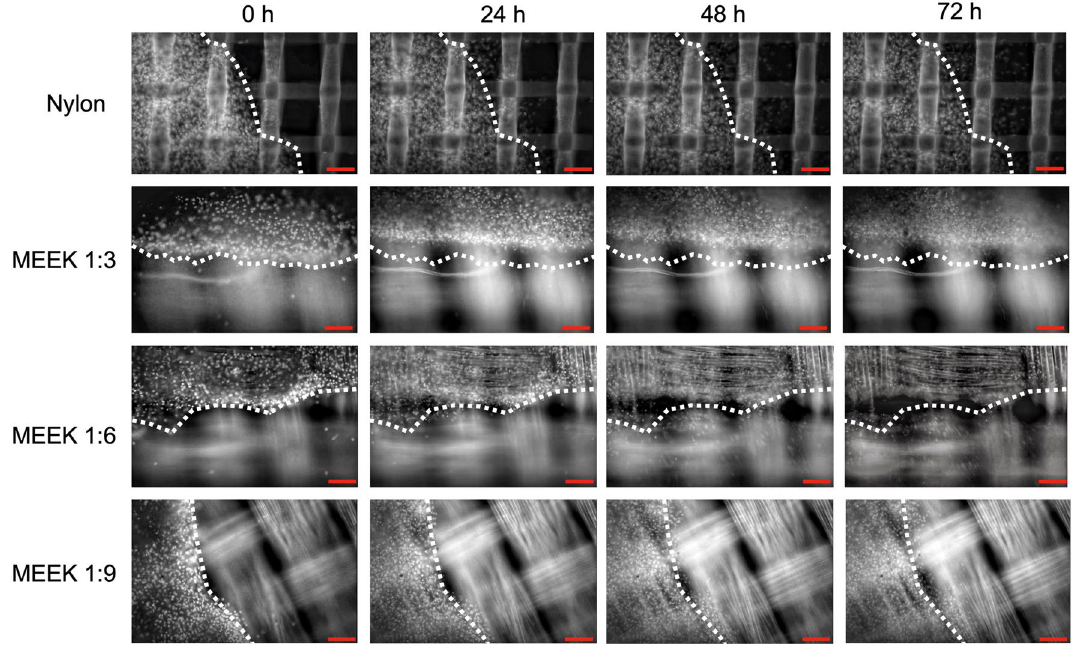
Figure 5. Fibroblast migration on both nylon dressing and MEEK gauzes. Fibroblast movement was shown at 0, 24, 48 and 72 h on nylon dressing and MEEK gauzes at 1:3, 1:6 and 1:9 expansion ratios. The dotted lines indicate the initial edge of the cell sheet or cell sheet island. The scale bars represent 100 μm.